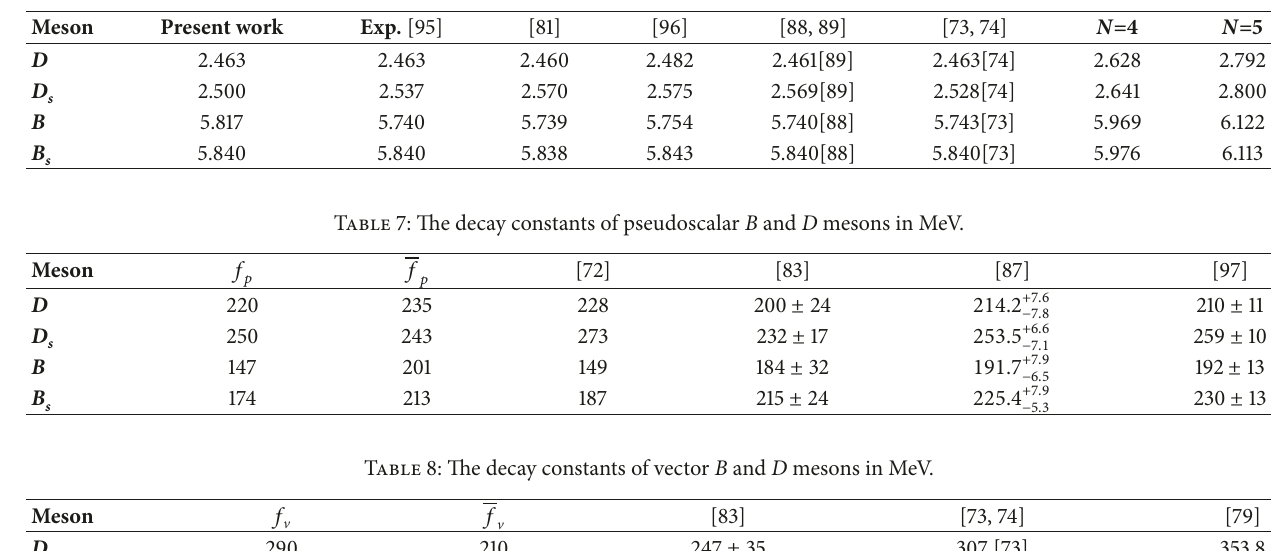
Table 6: Masses for mesons with p-wave state ( 2 S +1 𝐿 𝐽 = 3 𝑃 2 ) in GeV. 𝑎 = 0.0163 GeV 3 , 𝑏 = 0.113 GeV 2 , and 𝑐 = 6 × 10 −5 .